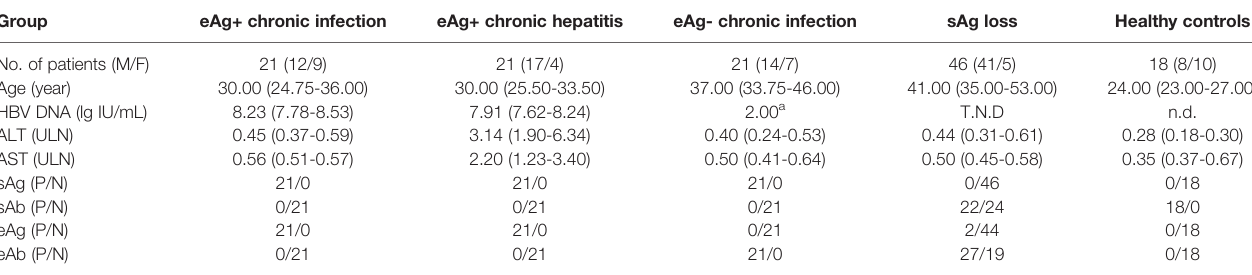
TABLE 1 | Clinical characteristics of the cross-sectional study subjects. Group eAg+ chronic infection eAg+ chronic hepatitis Healthy